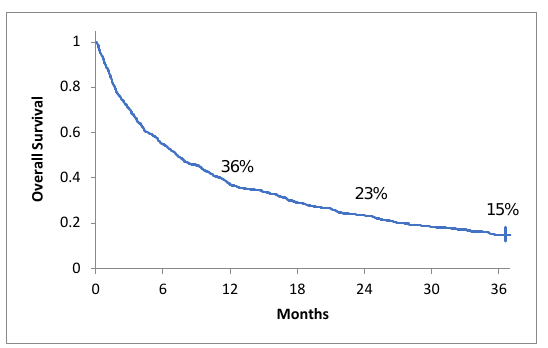
Figure 2. Complications according to the site of metastases.